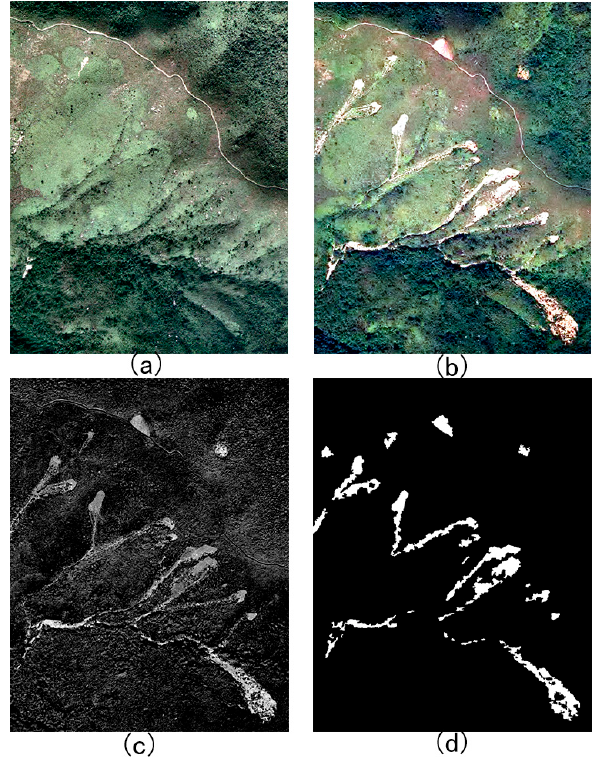
Figure 9. Second dataset: Digital Orthophoto Map acquired by an aerial plane in: ( a ) April 2007; and ( b ) July 2014; ( c ) corresponding CMI generated through the difference method; and ( d ) reference of the changed area caused by the landslide.